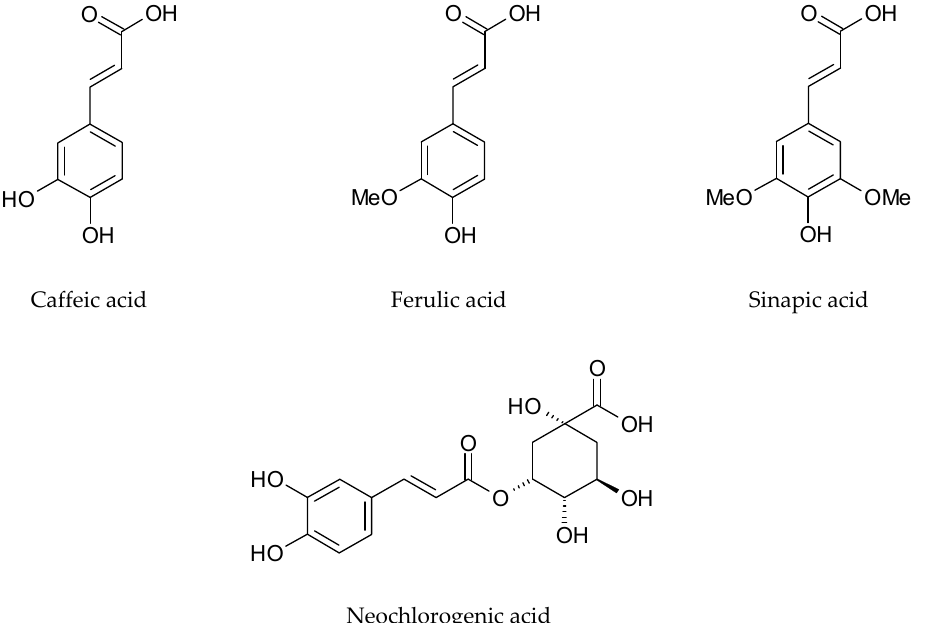
Figure 6. Chemical structure of representative phenolic acids of I. tinctoria L.